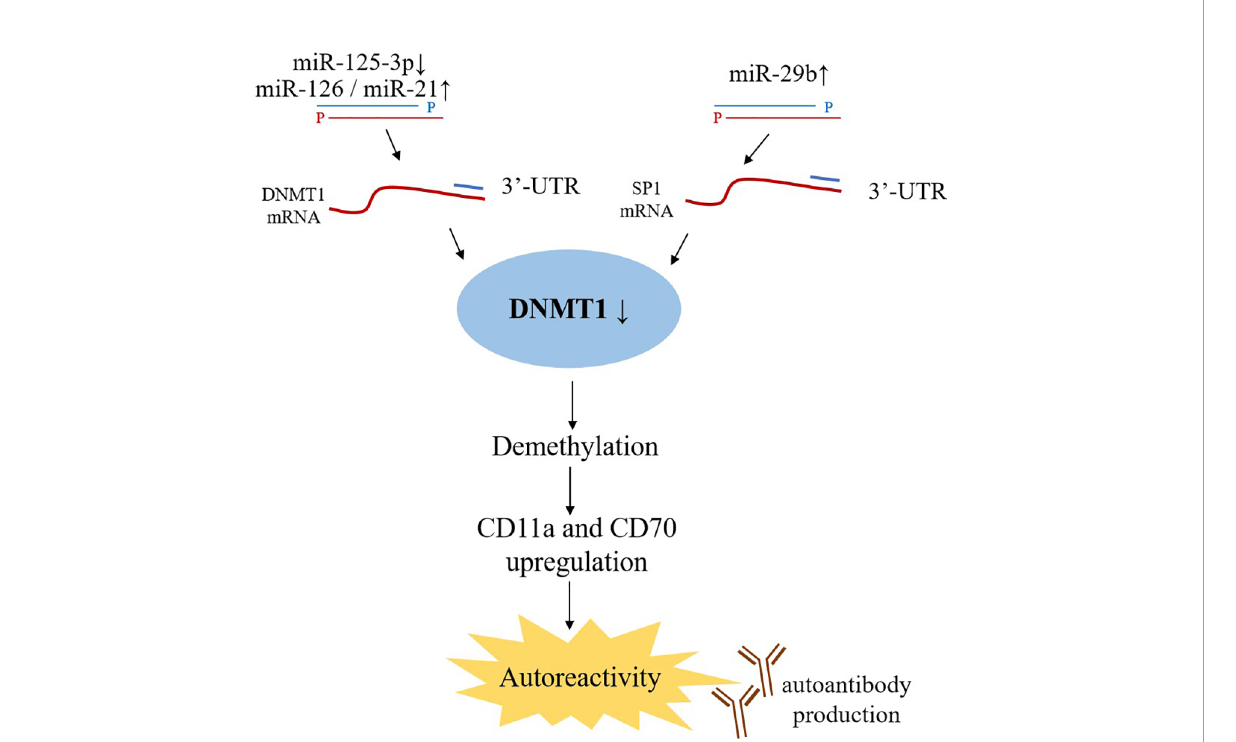
FIGURE 3 Effects of miRNAs on DNA methylation. miR-21 and miR-126 binding to the 3 ’ UTR in DNMT1 mRNA lead to DNMT1 protein decreased, while miR-29b targets 3 ’ UTR of SP1 mRNA indirectly inhibiting DNMT1 expression. As a key component of DNA methylation, decreased DNMT1 expression upregulates the level of CD11a and CD70, which ultimately trigger autoreactivity and amount of autoantibodies